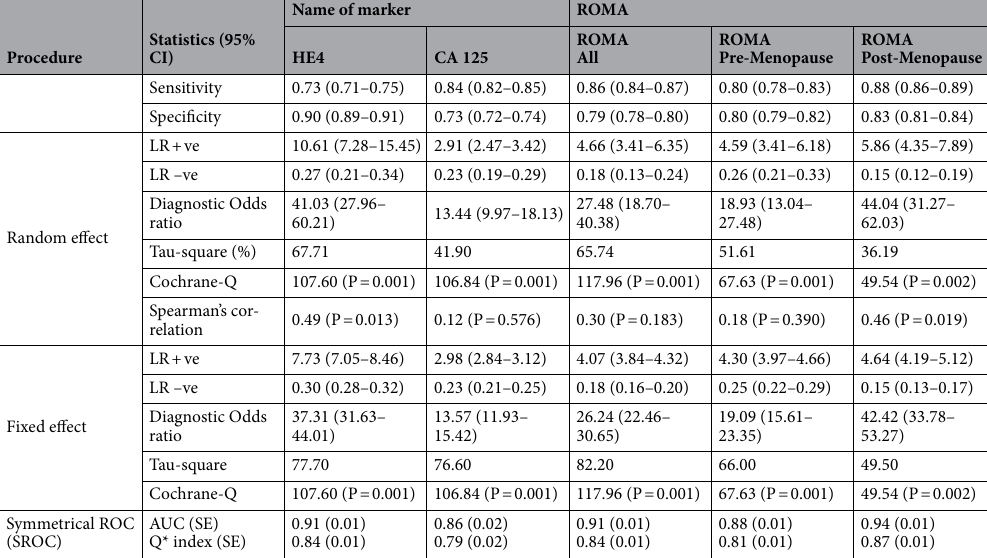
Table 2. Comparison of diagnostic measures by three serum markers. Human epididymis secretory protein 4 (HE4), Cancer antigen (CA125) and Risk of Ovarian Malignancy Algorithm (ROMA). Positive